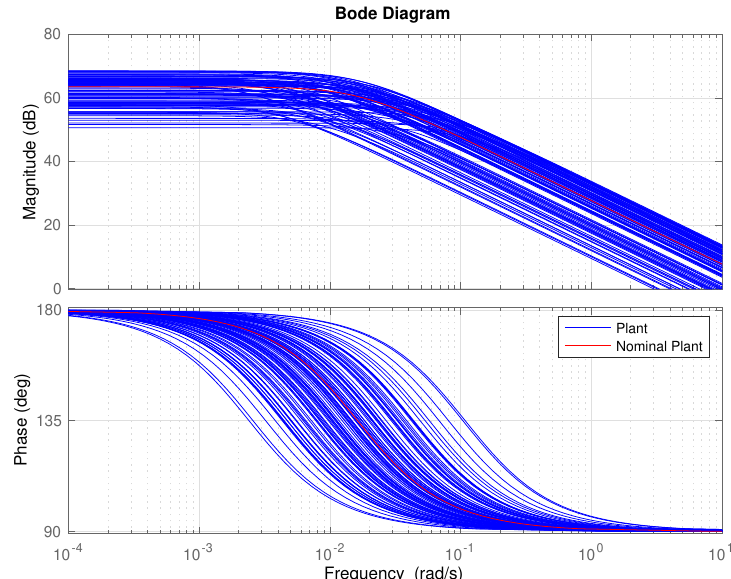
Figure 6. Bode Diagram for linear plants obtained around different equilibrium points.